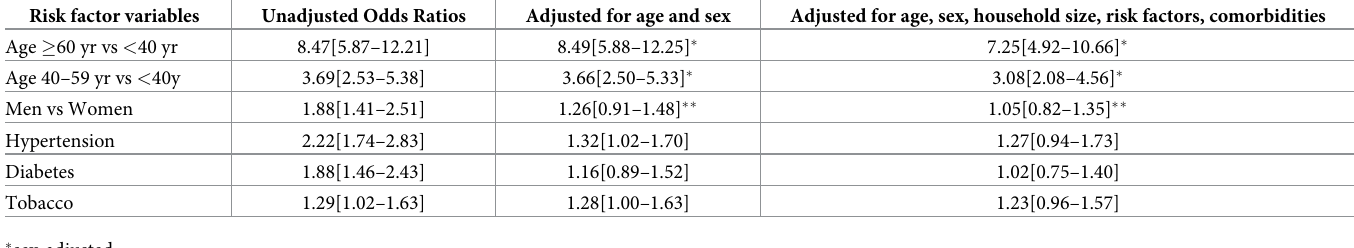
Table 6. Univariate and multivariate logistic regression analyses (odds ratio and 95% confidence intervals) for in-hospital deaths in various cardiovascular risk